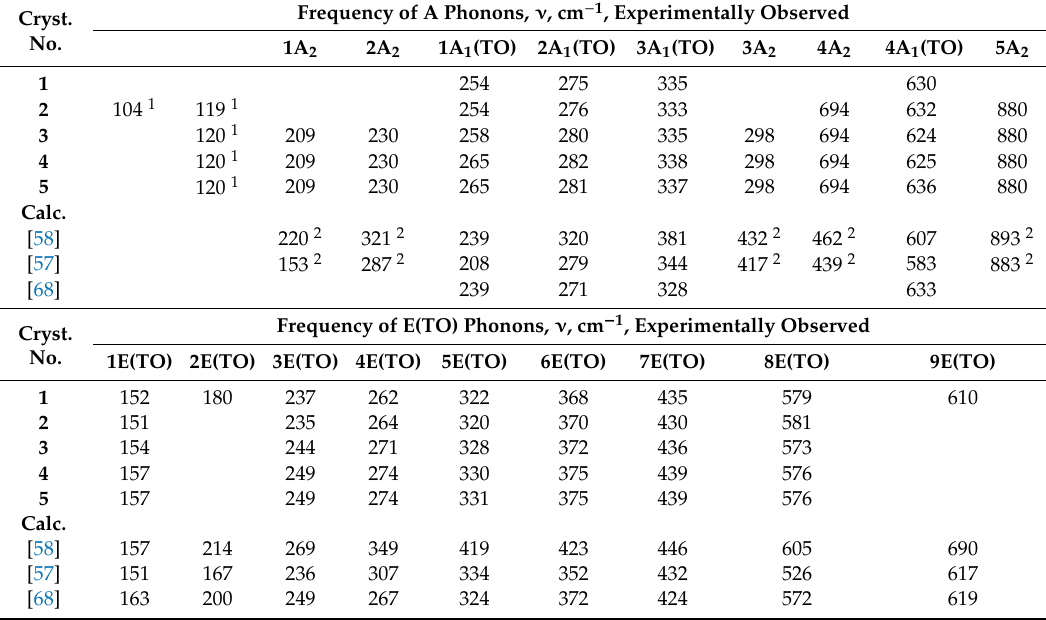
Table 3. Experimentally observed Raman bands (T = 100 K) of crystals: 1—SLN; 2—CLN; 3—LiNbO 3 :Zn (4.5 mol.% ZnO); 4—LiNbO 3 :Mg (5.1 mol.% MgO); 5—LiNbO 3 :Mg (5.3). Calculated frequencies of fundamental oscillations of A 2 , A 1 (TO) and E(TO) symmetry types. Cryst.